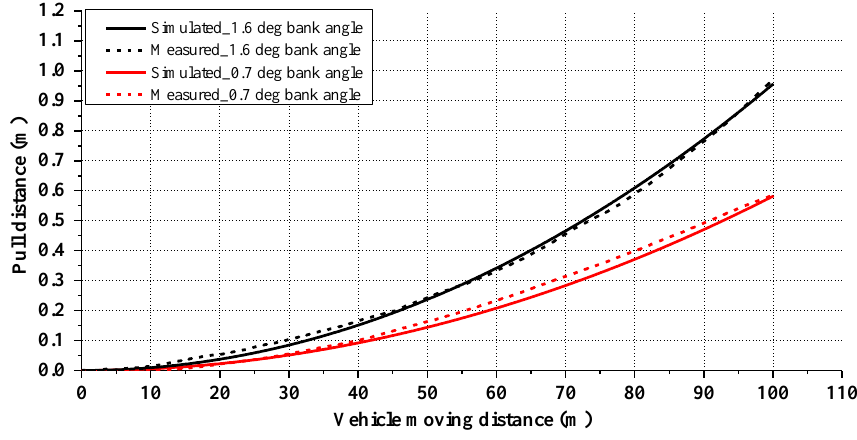
Figure 12. Verification results.